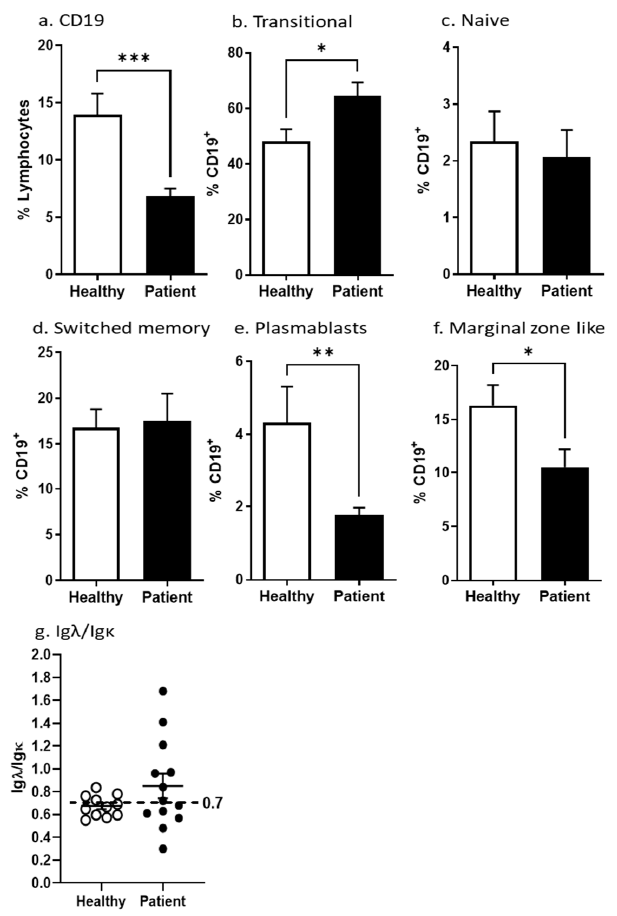
Figure 3. Peripheral B-cell compartment in prostate cancer patients and healthy donors. Buffy coat cells isolated from blood were stained and analyzed on a flow cytometer. Mean percentages of CD19 + B cells in total lymphocytes and of the B-cell subpopulations in CD19 + lymphocytes are shown. Ig λ /Ig κ isotype distribution was determined by flow cytometry. The proportion is calculated by dividing Ig λ with Ig κ percentages of CD19 + cells. All error bars indicate SEM. Percentages of lymphocyte subpopulations were compared with the Student two-tailed t -test. p : * ≤ 0.05, ** ≤ 0.01 *** ≤